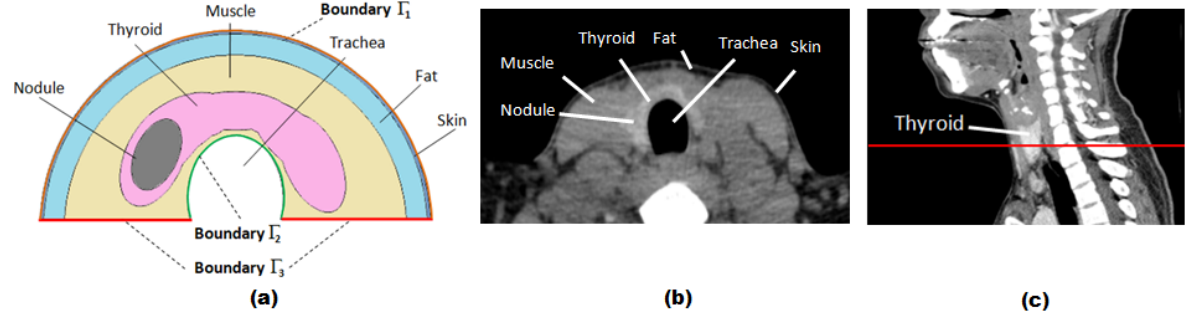
Figure 3. Simplified 2D geometry used in the FE simulations ( a ) based on the best CT view of the thyroid gland ( b ) that is the cross section of the neck represented by the red line of the sagittal CT slice on ( c